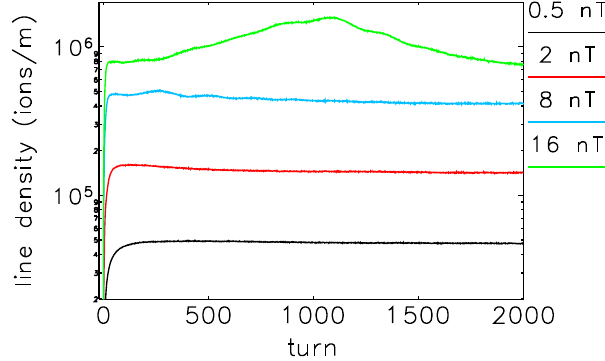
values.FIG. 11. Ion density for different pressure values. Note the log scale on the vertical axis.